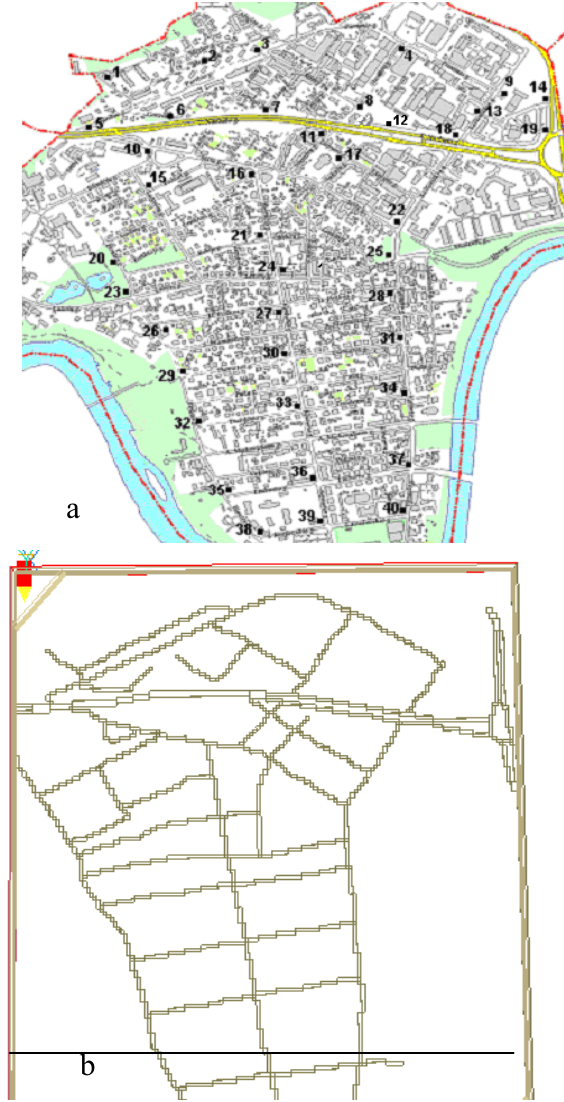
Fig. 1. Žvėrynas map: a – map with 40 measuring points in the streets; b – streets marked within the digitized area the speed wss 1.8 m/s measured using the “Phoenics “ post-processor